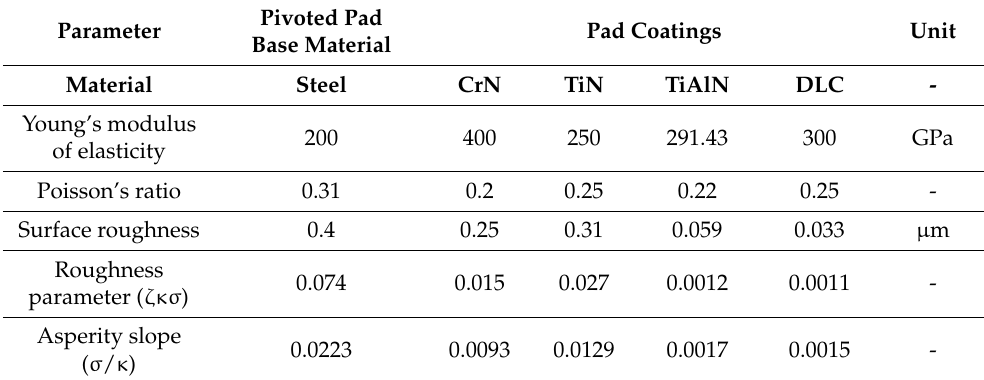
Table 6. Coating properties and surface topographical parameters for the pivoted pad thrust bearings. Parameter